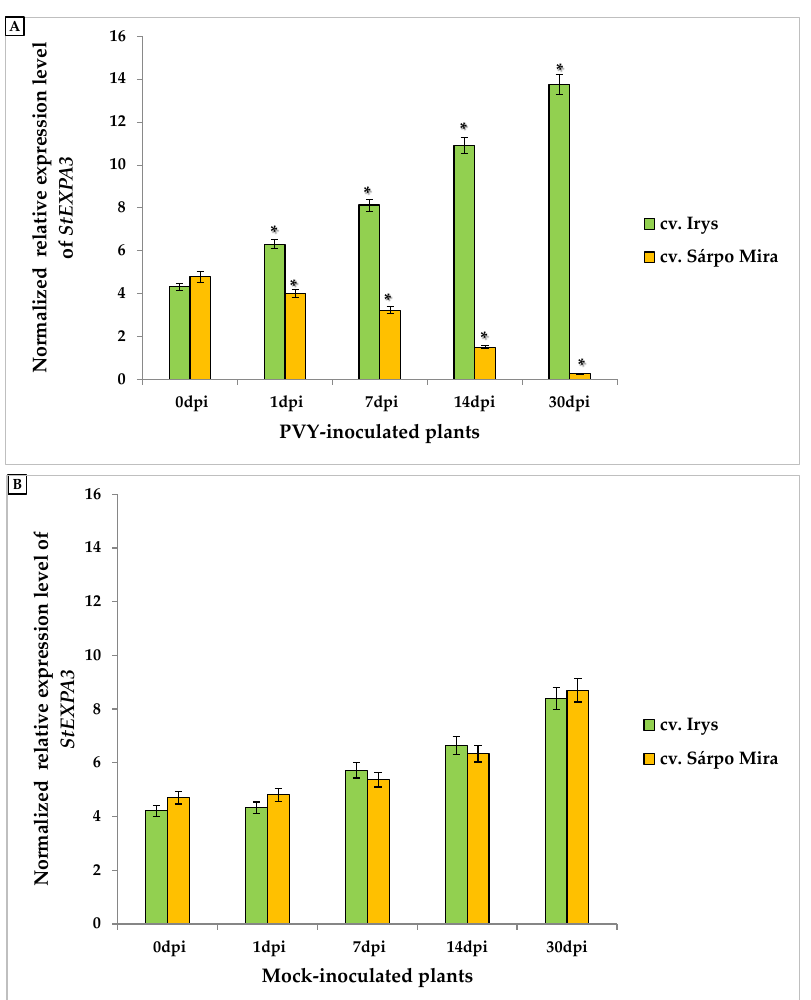
Figure 1. The normalized relative expression levels of StEXPA3 calculated based on the reference gene StEf1 α in potato virus Y (PVY)-inoculated ( A ) and in mock-inoculated ( B ) cv. Irys and cv. S á rpo Mira leaves between 0 to 30 dpi in combination with ANOVA. Mean values of normalized expression levels were evaluated at the p < 0.05 level of significance using a post-hoc Tukey’s honest significant difference test (Tukey HSD test). Statistically significant values on different days after mock or viral inoculation for the cultivars are marked by asterisks (*) above the mean value of the normalized expression on each